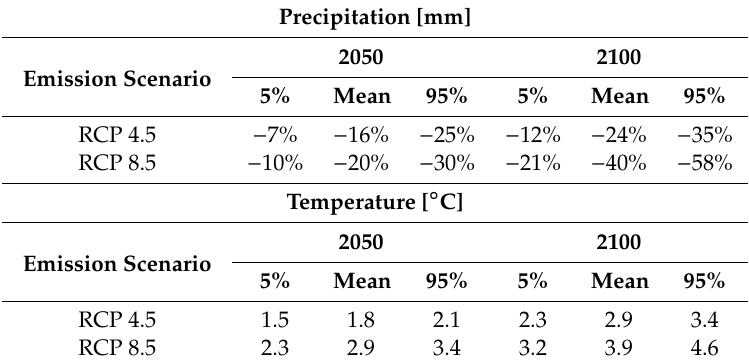
Table 5. Climate data projections for the two emission scenarios used in this study.